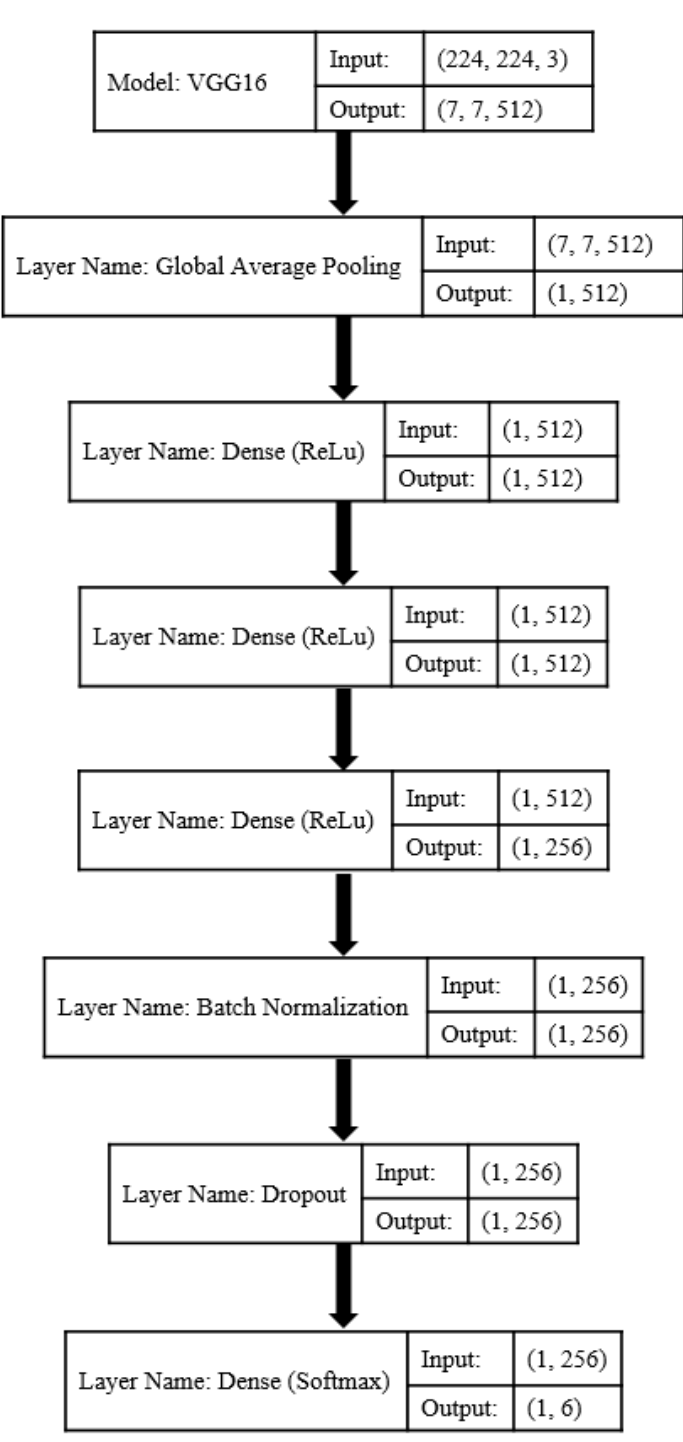
Figure 5. The proposed framework for grapevine cultivar identification.